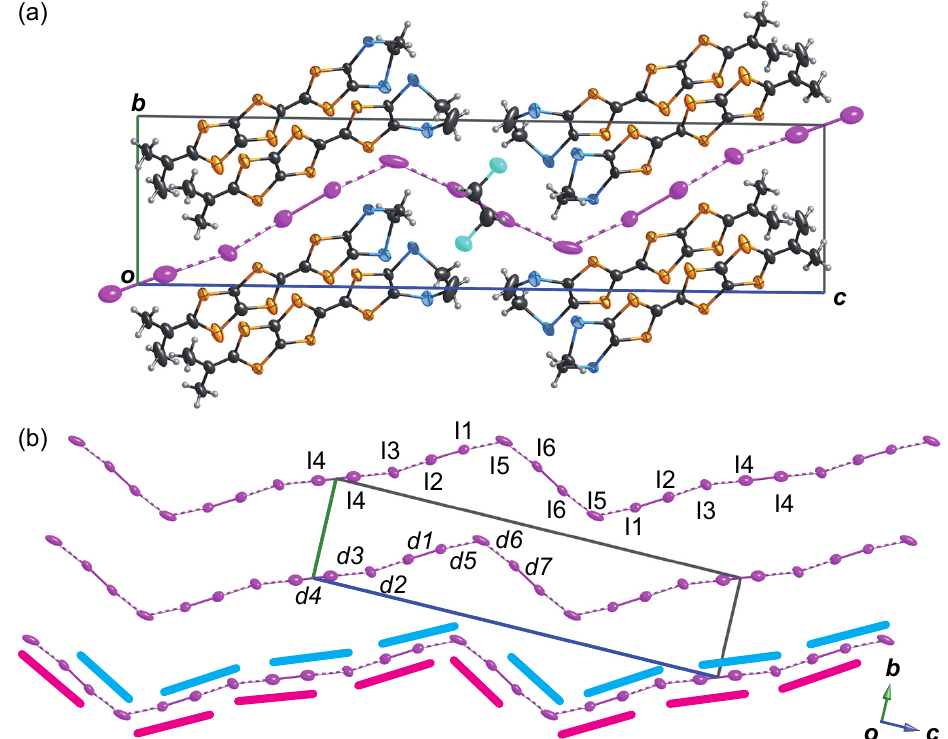
Figure 14. ( a ) Crystal structure of 6 viewed along the a axis; ( b ) Iodine chain structure in 6 with the atom numberings. Interatomic distances are d1 = 2.900(2), d2 = 3.271(2), d3 = 3.352(2), d4 = 2.950(2), d5 = 3.471(3), d6 = 3.445(3), and d7 = 2.935(2) Å. Two − ion are depicted as light blue and pink patterns of configuration model of I 3